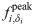
Regional excitation causes local and downstream changes to brain areas’ power spectra in different frequency bands at WP1.(A) Schematic of a brain network depicting the stimulated site i in brightest red. The black arrows point to two other regions j and k that lie at progressively further topological distances from the perturbed area in the structural network. In this figure, regions i, j, and k correspond to brain areas 1 (R–Lateral Orbitofrontal), 4 (R–Medial Orbitofrontal), and 10 (R–Precentral), respectively. (B) Left: A segment of region i’s activity time-course in the baseline condition. Right: A segment of region i’s activity time-course when it is stimulated. (C) Power spectra of area i and two other downstream regions j and k. In all three panels, the lighter curves correspond to the baseline condition, and the darker curves correspond to the state in which i is driven with additional input. The gray vertical lines indicate the peak frequency fi,δipeak of region i in the excited condition. (D) Histogram of the shift in peak frequency Δfi,δipeak induced by stimulating unit i, plotted over all choices of the perturbed area. (E) Distribution of peak frequencies of all units in the baseline condition {fipeak} (light gray) and distribution of the peak frequency units acquire when directly excited {fi,δipeak} (dark gray). (F) Average power spectra 〈psd〉j≠i over all units j ≠ i at baseline (light gray) and when unit i is perturbed with additional input (dark gray). (G) Average difference 〈Δpsdj,δi〉j≠i of the spectra of unit j ≠ i when unit i is excited and in the baseline condition, where the average is over all units j ≠ i. For reference, the light gray vertical lines denote the minimum and maximum peak frequency across units in the baseline state, and the dark gray line indicates the peak frequency acquired by the stimulated region i. Shaded boxes denote two frequency bands of interest: (1) the baseline band (purple) consisting of the main oscillation frequencies of brain areas under baseline conditions, and (2) the excited band (green) centered around the peak frequency that the stimulated region inherits. In subsequent analyses, we assess perturbation-induced changes in the PLV between brain areas in the baseline band, Δρδibase (purple), and in the excited band Δρδiexc (green).